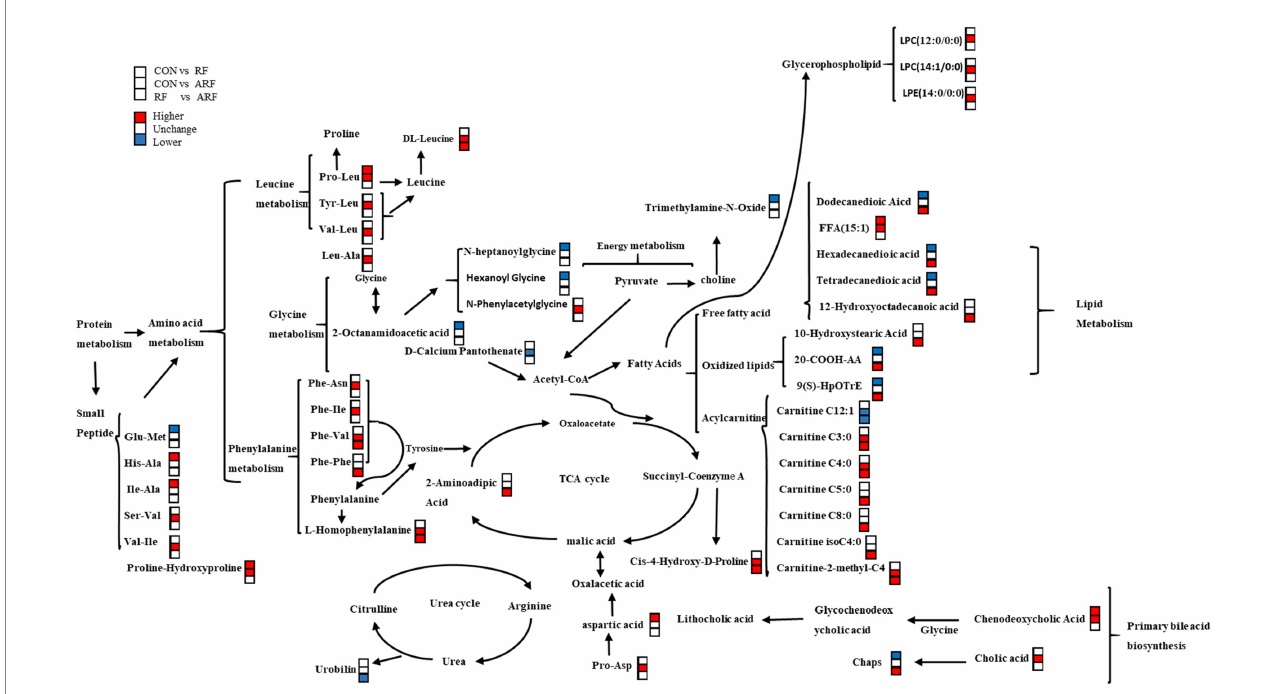
FIGURE 8 Correlation networks of fecal metabolites in CON, RF, and CON groups. Compared with the latter group, among the metabolites in the former group, the red symbol represents a significant increase, the white symbol represents no difference, and the blue symbol represents a